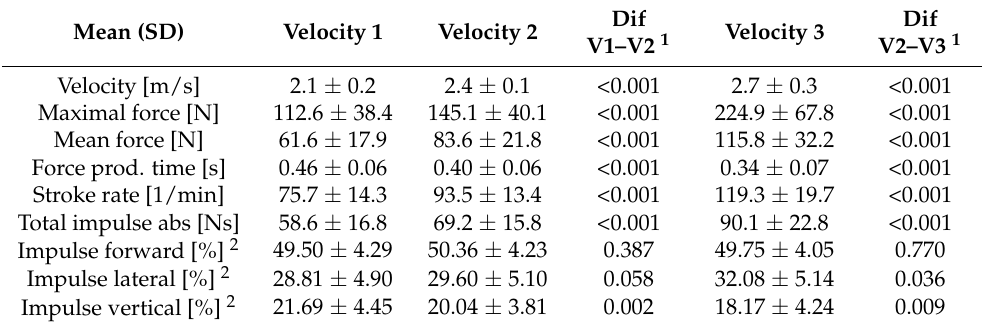
Table 3. Descriptive characteristics of the participants and results of the testing velocities ( n = 14).